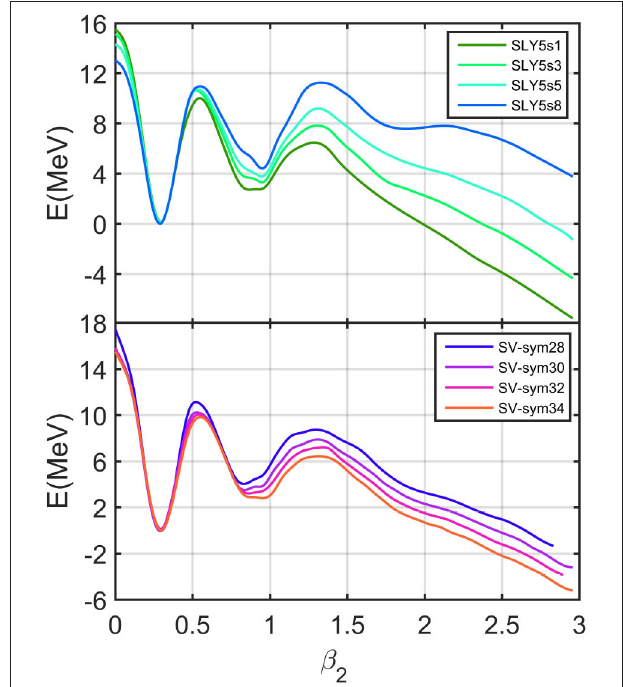
FIGURE 1 | The fission barriers of 240 Pu calculated by Skyrme Hartree-Fock+BCS with SLy5s X and SV-sym forces, respectively. Calculations are performed with octupole deformations but without triaxial